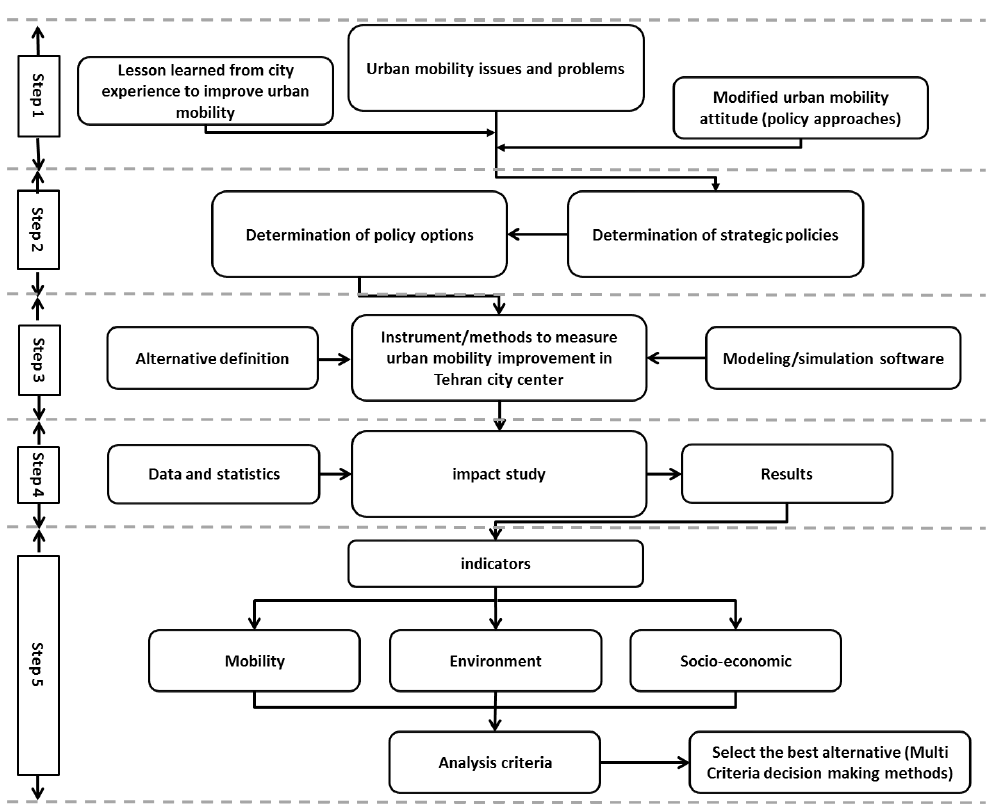
Figure 4: Conceptual framework of the